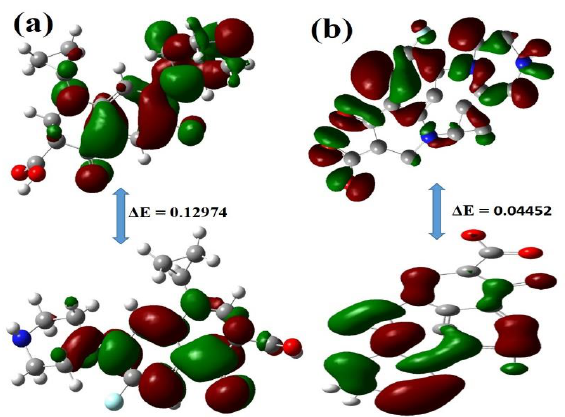
Figure 10. Interaction mechanism of CIP in neutral form ( a ) and zwitterion form ( b ) with modified biochar based on HOMO and LUMO.